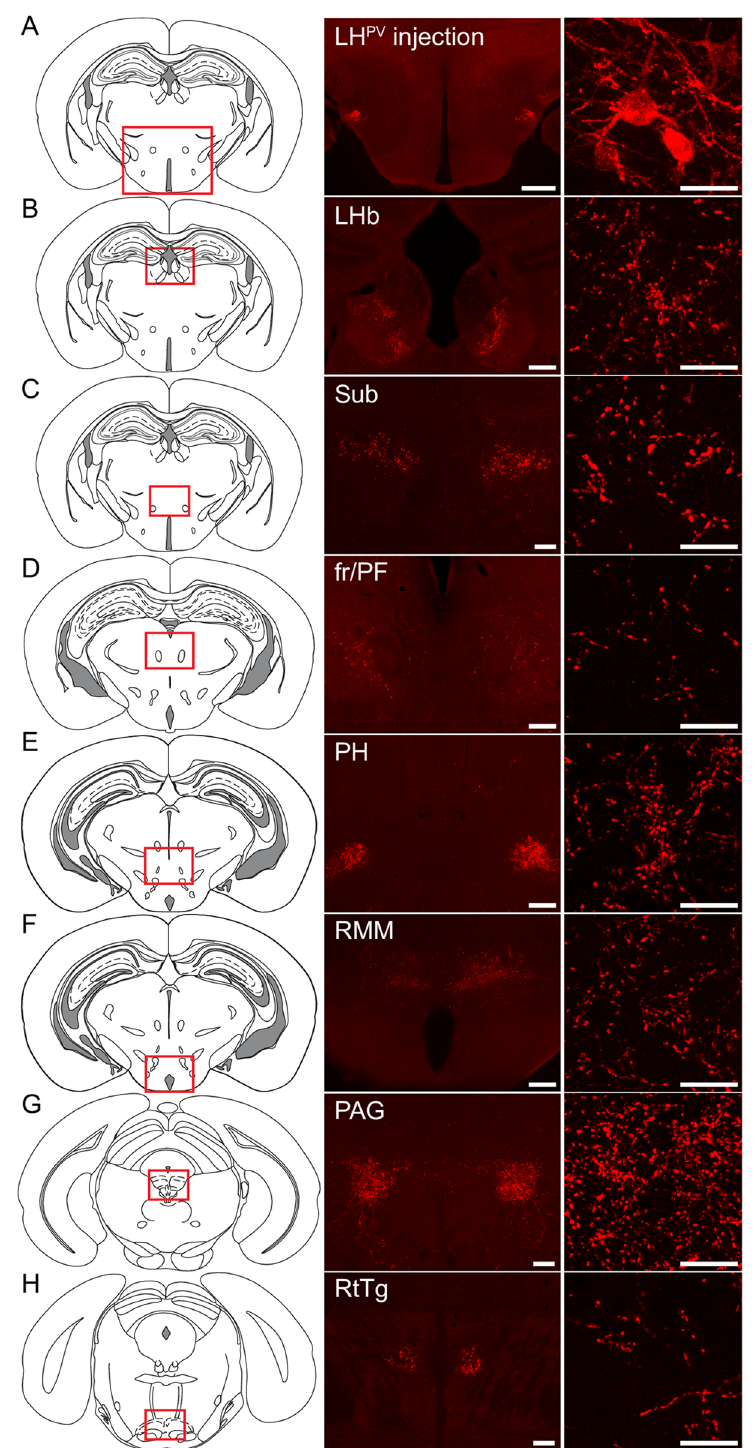
Fig 4. Axonal projections of LH PV neurons. (A) Schematic and representative image depicting a bilateral injection of the Cre recombinase-dependent viral vector for anterograde tracing (rAAV2/9-hEf1 α -DIO-synaptophysin-mCherry) into the lateral hypothalamus (LH) of a Pvalb IREScre mouse. Scale bar 500 μm. Representative images of projections to (B) the lateral habenula (LHb), (C) the submedius thalamic nucleus (Sub), (D) the parafascicular thalamic nucleus (PF) surrounding the fasciculus retroflexus (fr), (E) the posterior hypothalamus (PH), (F) the retromamillary